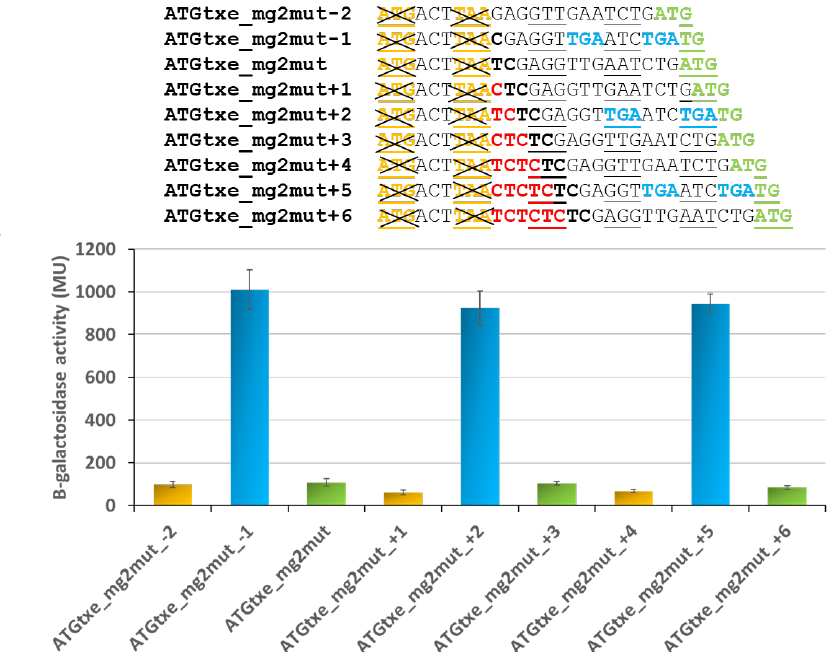
Figure 6. Upon mg2 inactivation, translation of lacZ persists in case of a specific shift in the open reading frame ( − 1, +2, and +5). ( A ) Nucleotides that were deleted in two derivatives are indicated in black bold, while inserted nucleotides are displayed in red bold. Codons in the same reading frame as ATG2 are underlined. Newly created stop codons are highlighted in bold blue. ( B ) β -galactosidase activities were assessed in the E. coli ∆ 5 ∆ lac strain carrying pRW225 derivatives, as indicated on the graph. Reporter activity was measured when cell cultures reached OD600 ≈ 0.5. The same colors are kept for the same open reading frame. These results are the average of at least three independent experiments; error bars represent standard deviation (S.D.). Calculated p -values for blue bars showed no statistically significant differences between